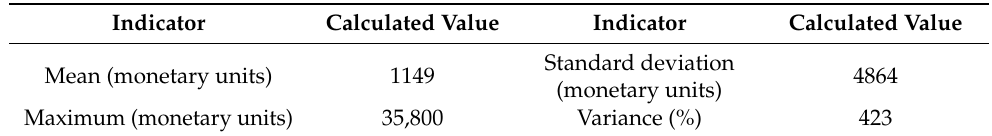
Table 2. Descriptive statistics for the “risk”